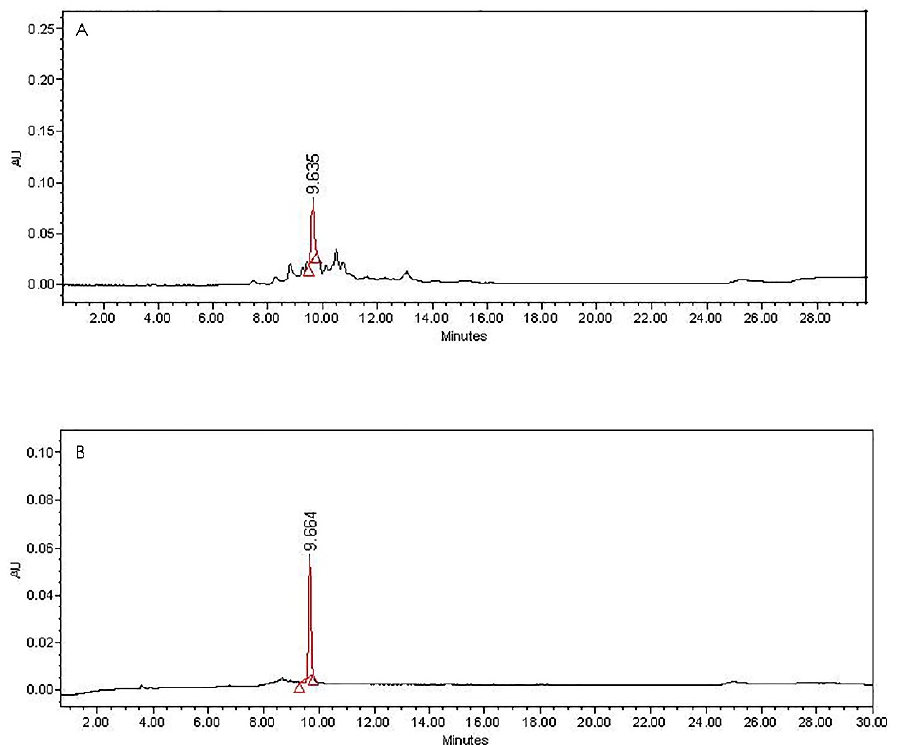
Figure 2. HPLC chromatogram of the ( A ) F10AC fraction and ( B ) Luteoloside analytical standard.